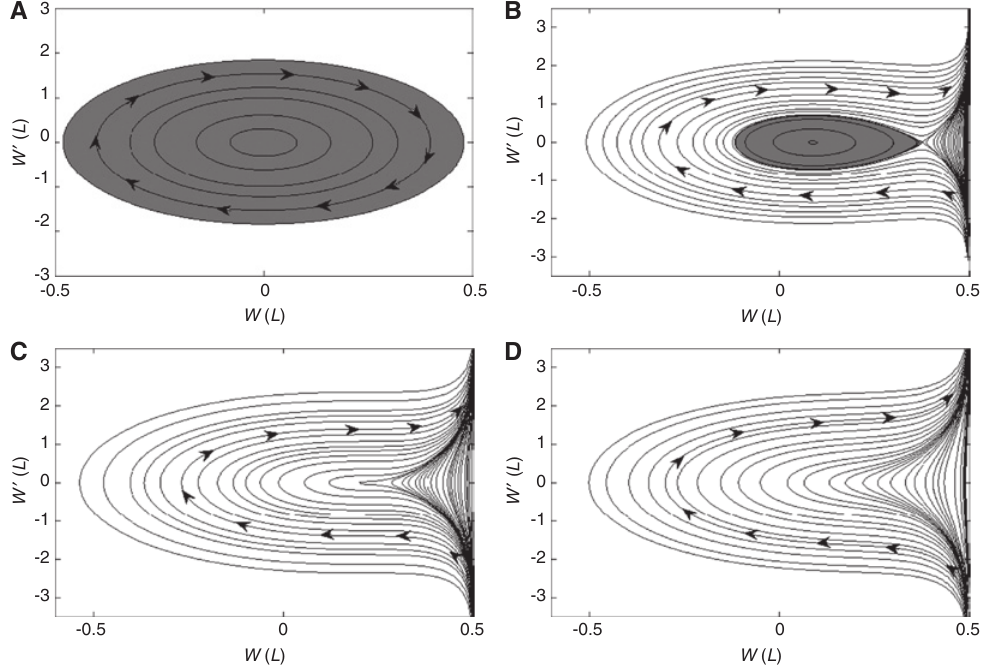
Figure 4 Phase portraits of the microbeams for different initial conditions: (A) V = 0, (B) V = 50, (C) V = 62.41, and (D) V = 70.